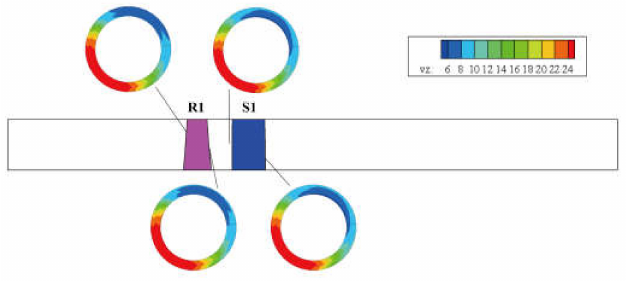
Figure 8. The distribution of axial velocity in mature stall cell. (R1: Rotor 1, S1: Stator 1).